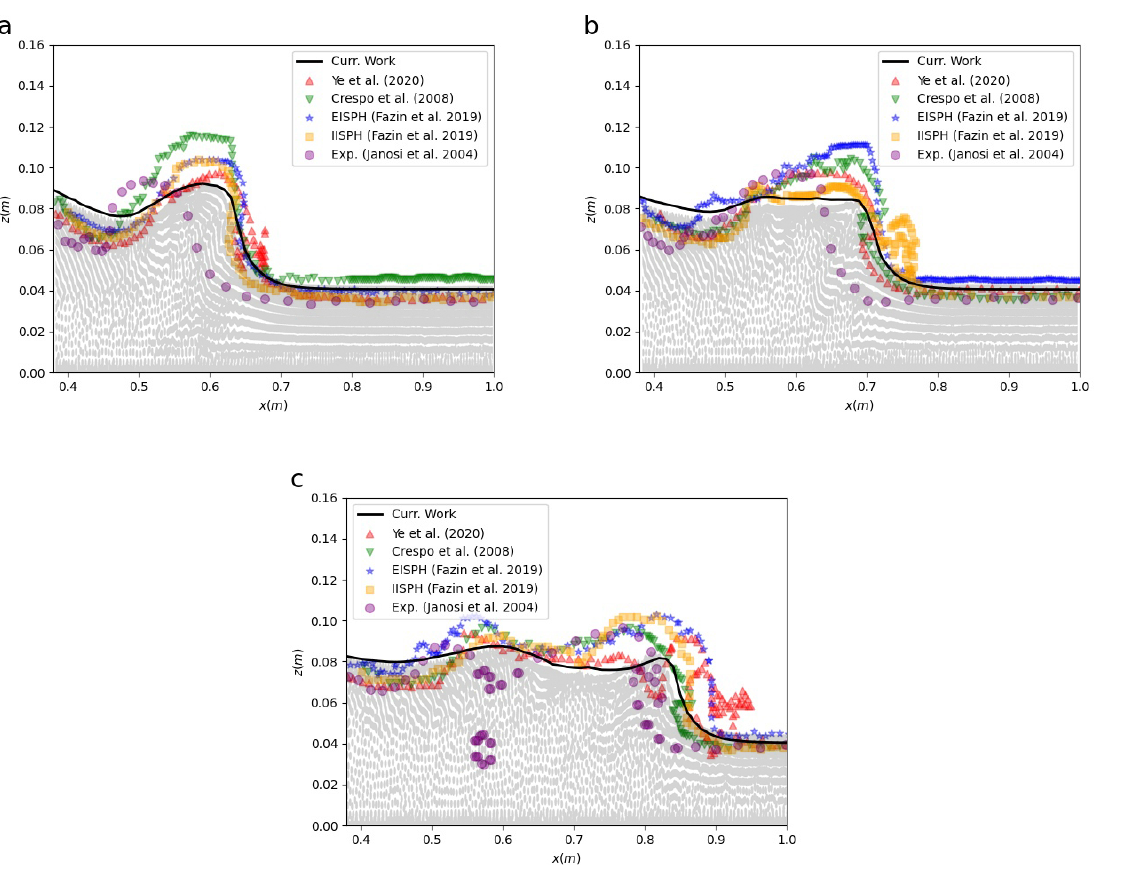
Figure 2. Comparison of dam-break process using the current kernel with some numerical [19–21] and experimental [22] results. ( a ) t = 0.280 s; ( b ) t = 0.345 s; ( c ) t = 0.470 s.